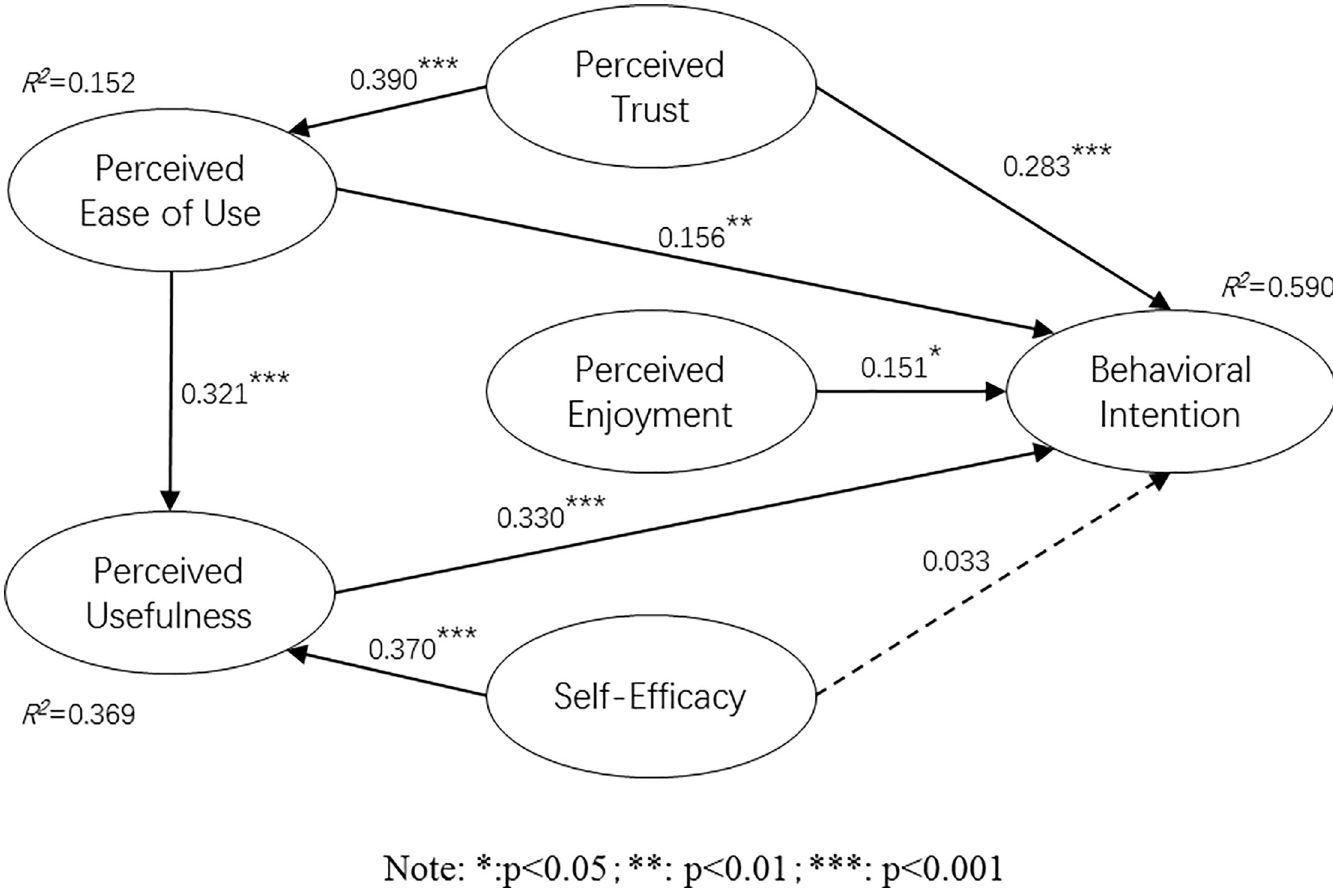
Fig 2. Model verification